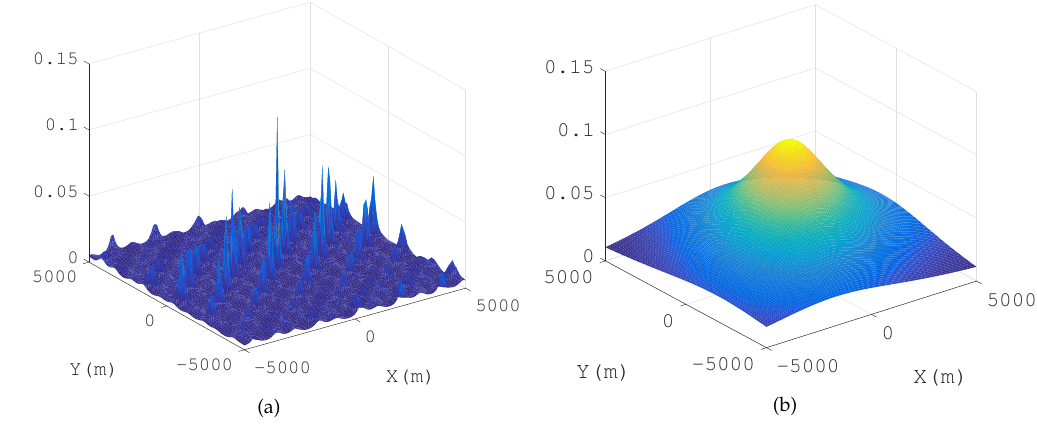
Figure 2. Multiple-peak cost function of a frequency band signal and single peak cost function of a base band signal. ( a ) Cost function for a frequency band signal ( b ) Cost function for a base band